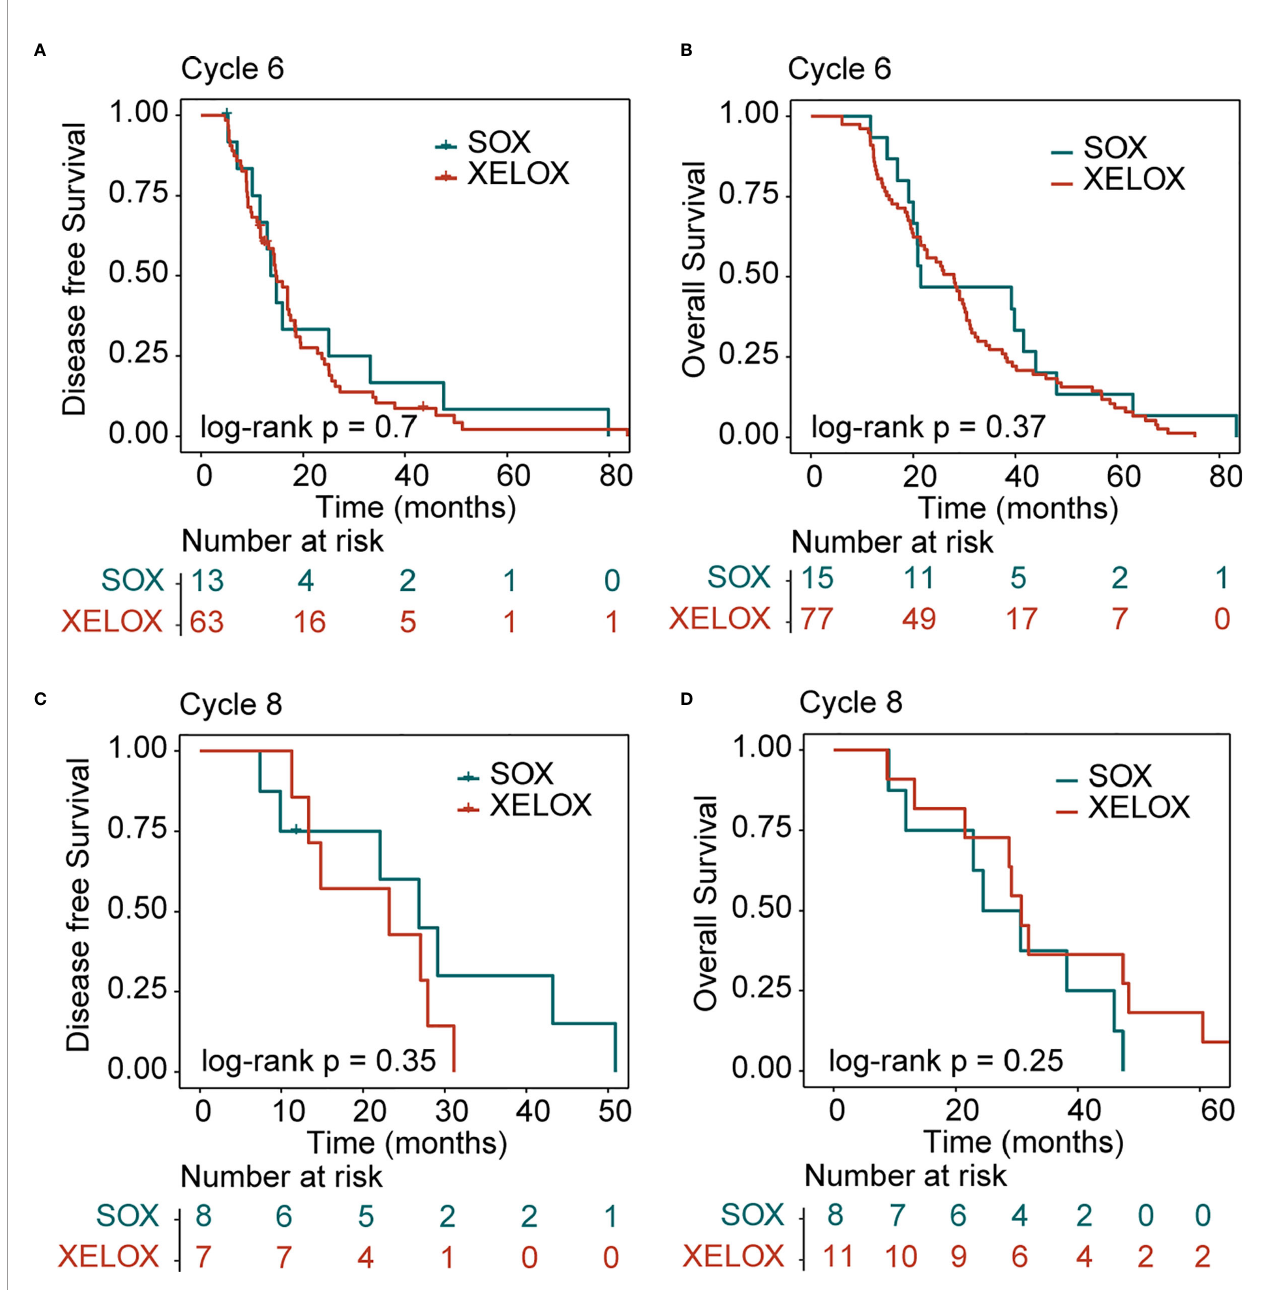
FIGURE 4 | Kaplan-Meier survival curves for disease-free survival (DFS) and overall survival (OS). DFS (A) and OS (B) analyses for XELOX and SOX regimens for patients with stage III gastric cancer receiving six cycles of chemotherapy. DFS (C) and OS (D) analyses for the XELOX and SOX regimens in stage III patients receiving eight cycles of chemotherapy. XELOX, Capecitabine plus oxaliplatin; SOX, S-1 plus